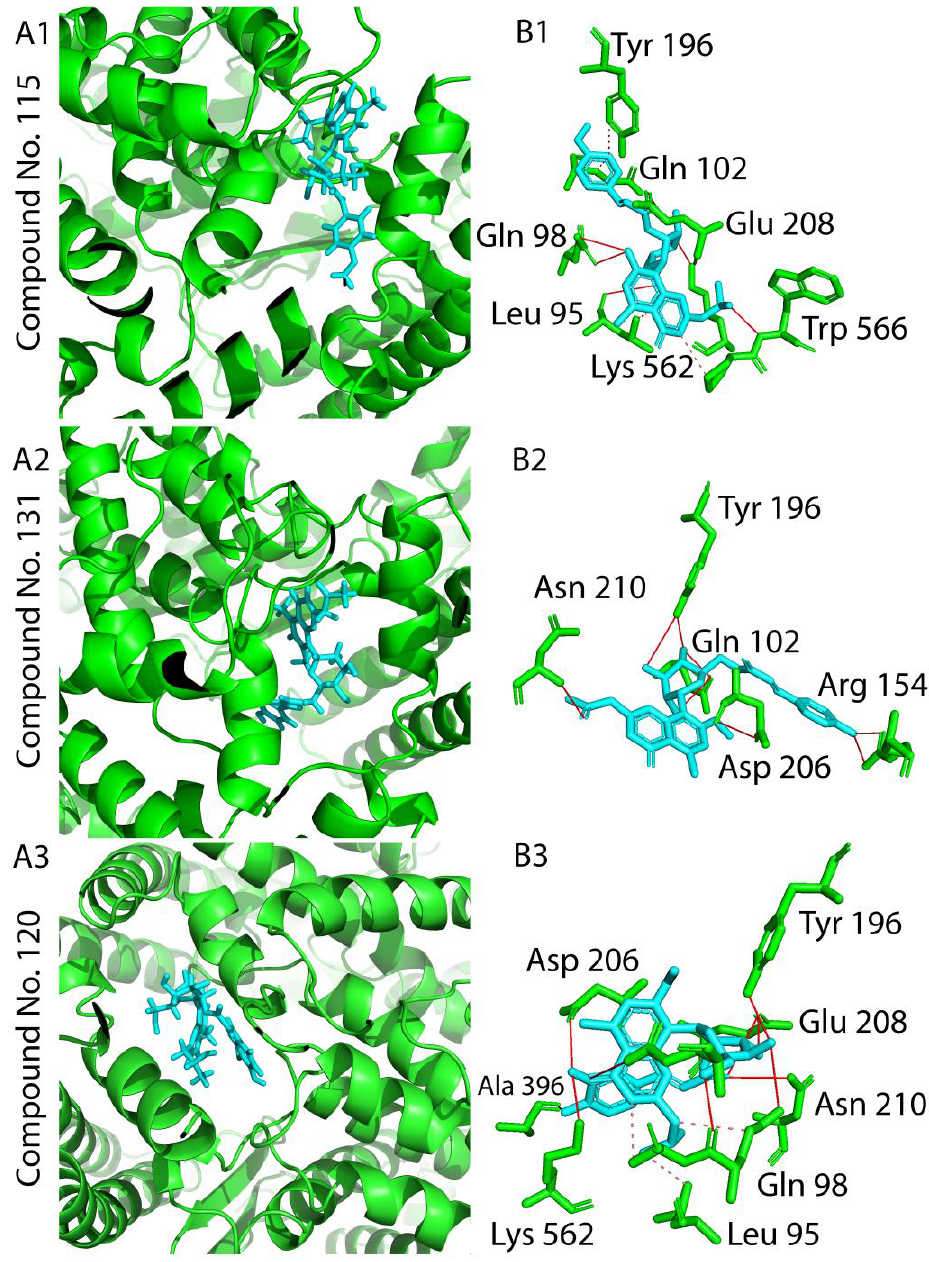
Figure 7. 2D and 3D docking interactions complexes of compounds 115 ( A1 , B1 ), 131 ( A2 , B2 ), and 120 ( A3 , B3 ) with SARS-CoV-2 spike glycoprotein. Solid red line: Hydrogen bonds. Dashed pink line: Hydrophobic interactions.